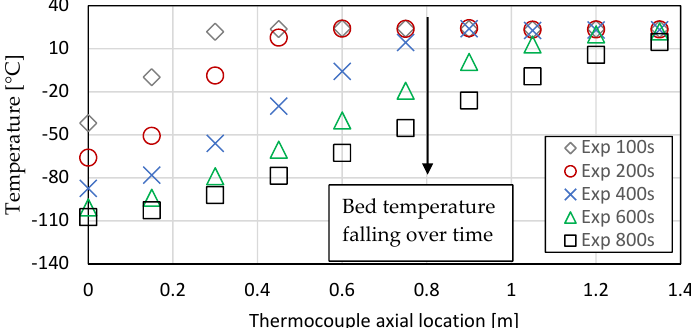
Figure 6. Experimental temperature front at different locations and timesteps. Packed bed filled with 10 mm quartzite gravel, Re = 2074.